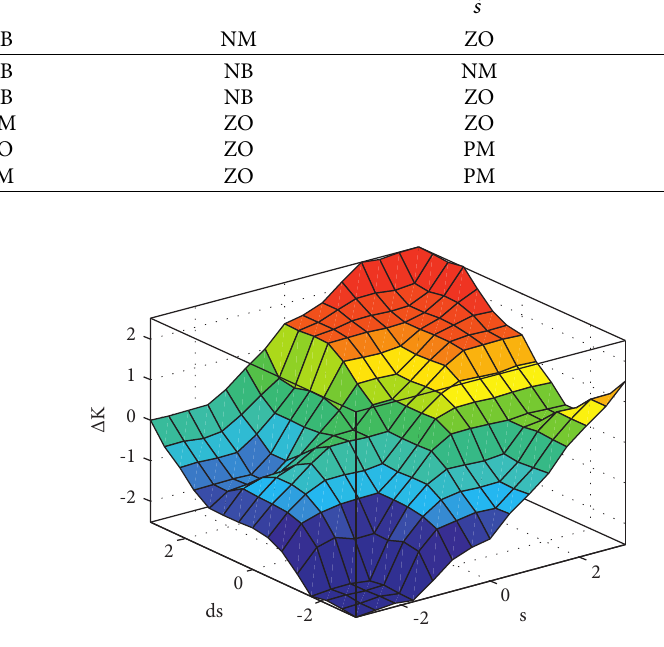
Figure 8: Input and output surface of the fuzzy inference